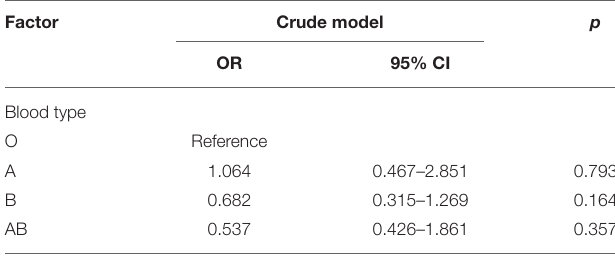
TABLE 4 | Multivariable logistic regression analysis of the relationship between CSDH recurrence and blood